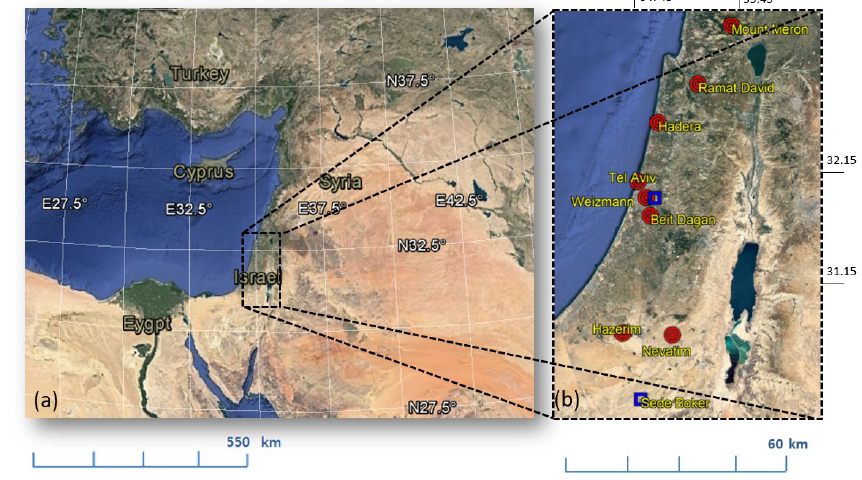
Figure 3. Google Earth map of the large domain (a) and Israel (b) with indications of eight ceilometer sites (red circle; details in Table 2) and two AERONET sites (blue square).